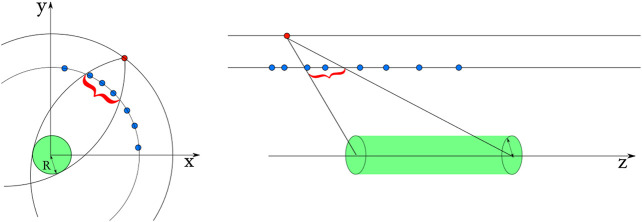
Windows opened in the transverse and longitudinal planes. The outer hit is colored in red, the inner hits in blue (Pantaleo, 2017).